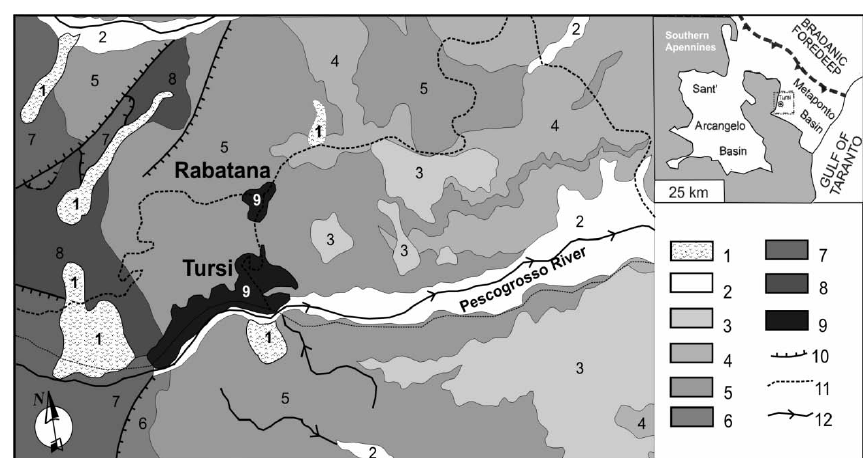
Fig. 2. Geological map of the Tursi-Rabatana site (after Lazzari et al., 2006). Legend: (1) Landslides; (2) Alluvial deposits; (3) Grey- blue clays Formation; (4) Fluvial terraces; (5) Tursi Group (lower Pleistocene); (6) Pliocene deposits; (7) Varicolours clays Formation (Cretaceous-Oligocene); (8) Flysch of Serra Palazzo (Miocene); (9) built-up areas; (10) main faults; (11) main roads; (12) water source (perennial